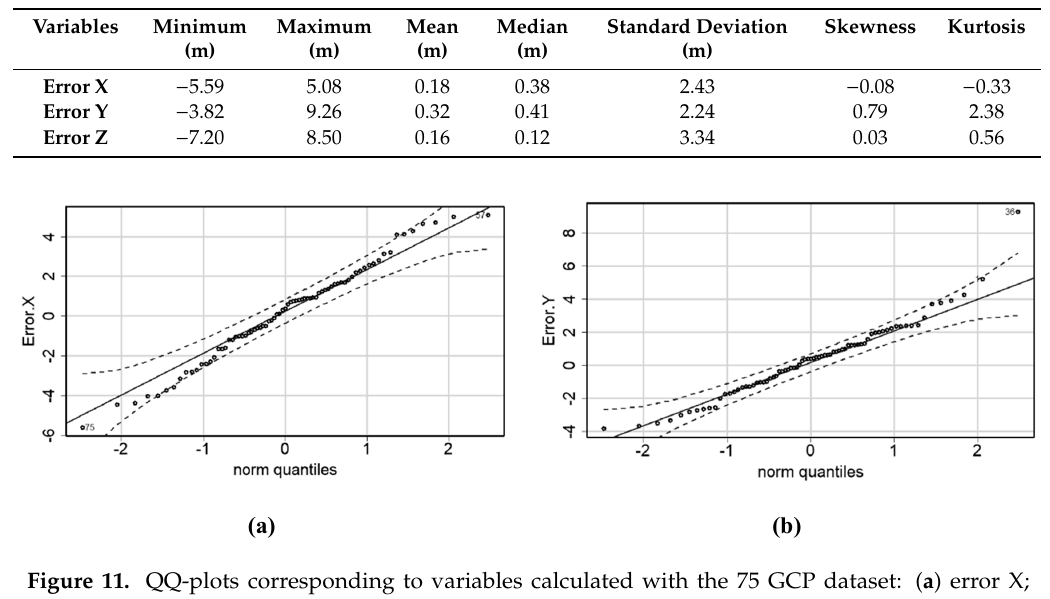
Table 6. Basic statistic of the 75 GCP dataset.